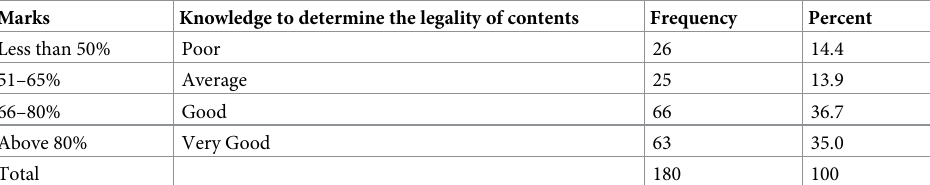
Table 2. Knowledge level (n =